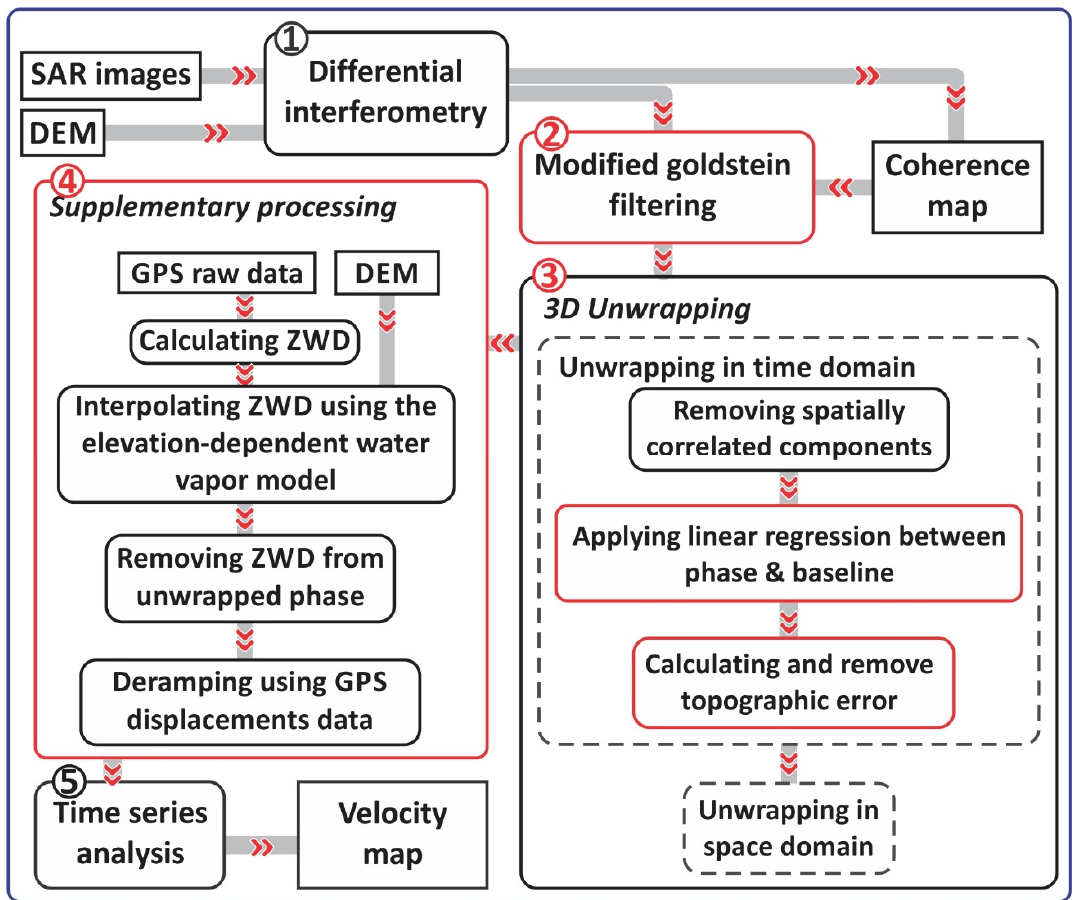
Figure 1. Improved SBAS diagram; the red boxes mark the modified and supplementary processing steps proposed in this